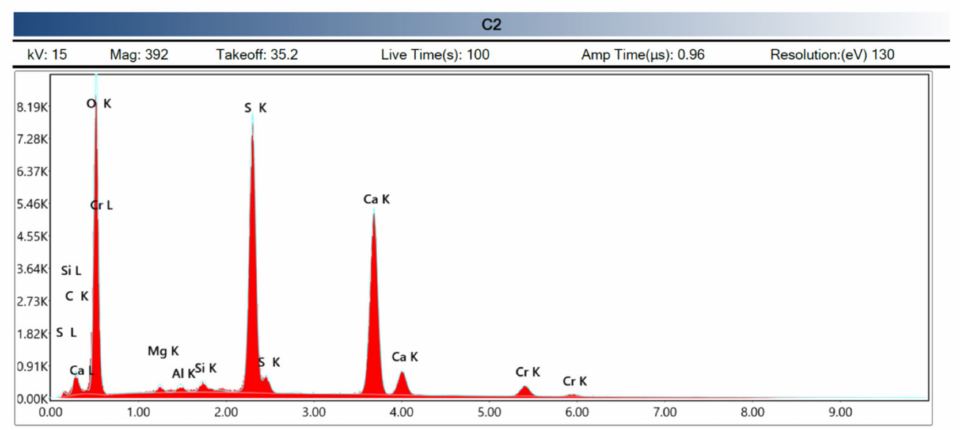
Figure 16. Analysis area and results for the compound (Source: the